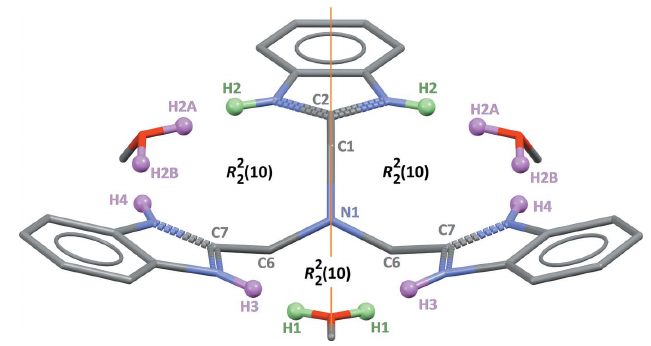
Figure 2 View of the title compound rotated by ca 90 (cid:5) in comparison with Fig. 1, showing the stair-like conformation for ntb. All H atoms bonded to heteroatoms are shown. Green H atoms are disordered by symmetry, while purple H atoms are positionally disordered, all having the same half occupancy. The orange line is the trace of the m mirror normal to the a axis.